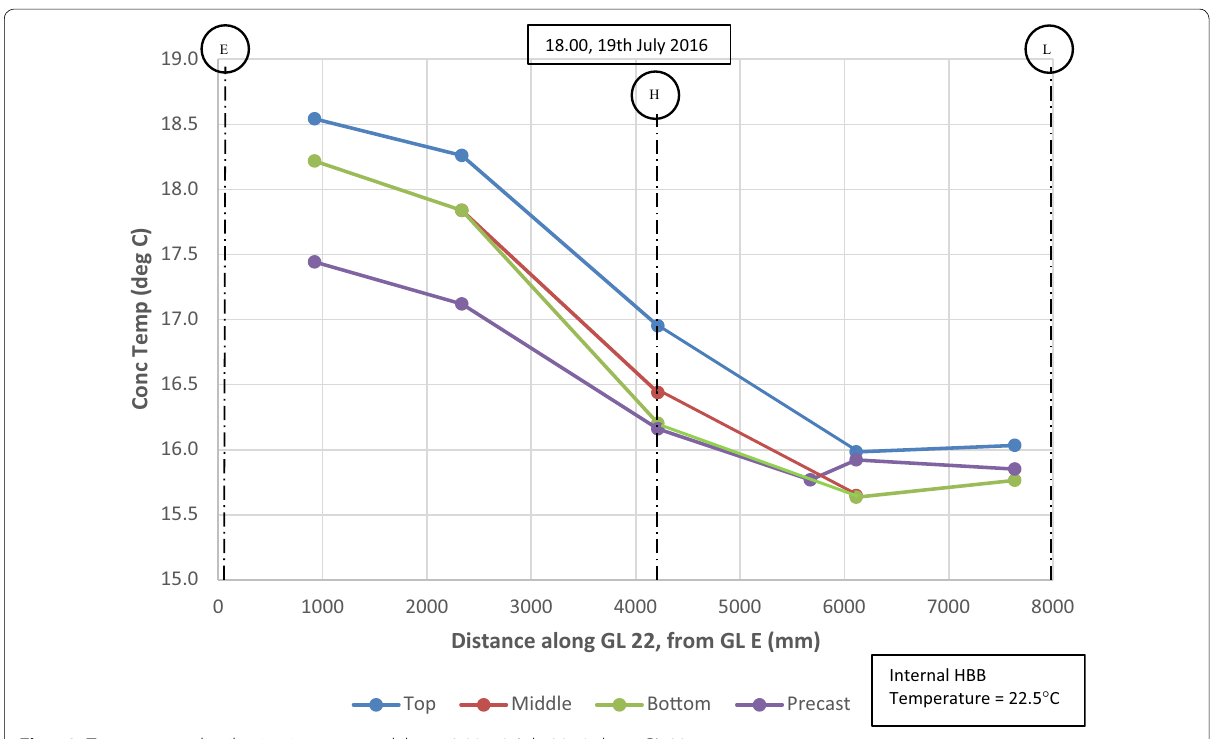
Fig. 13 Temperature distribution in concrete slab at 18.00, 19 July 2016 along GL